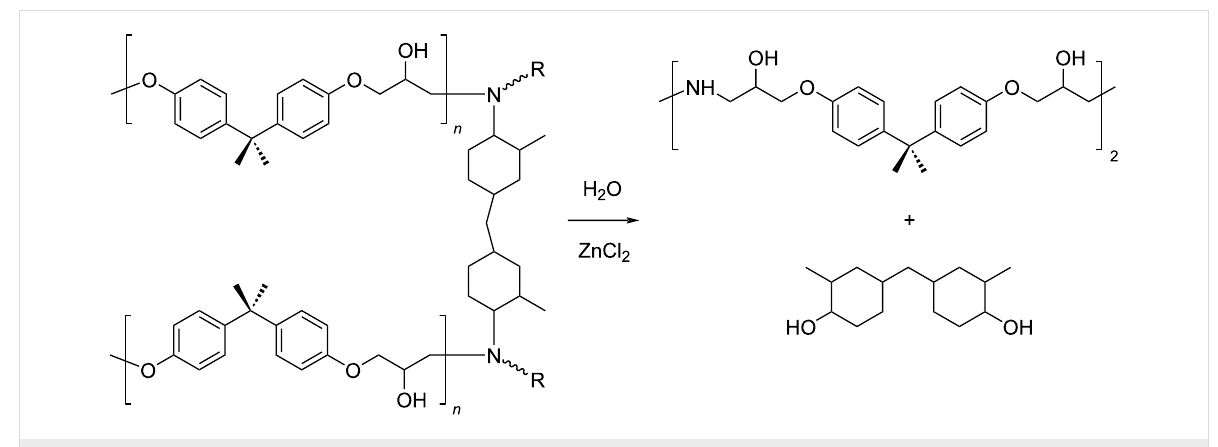
Scheme 23: Catalytic depolymerisation of epoxy resin/carbon fibres